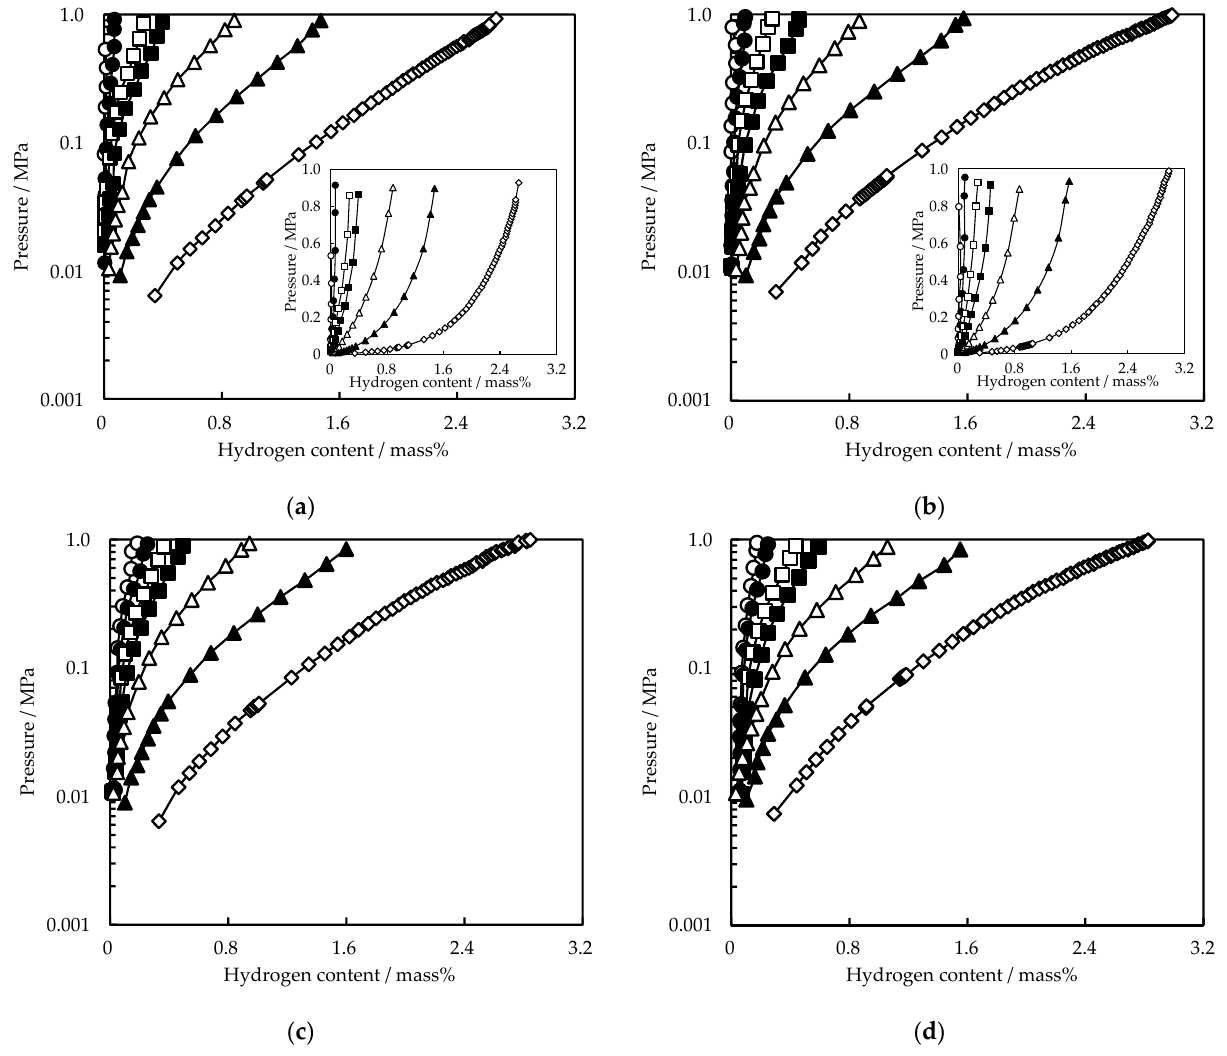
Figure 6. Hydrogen adsorption isotherms for ( a ) KB, ( b ) KB_0.6, ( c ) KB_4.9, and ( d ) KB_9.3. Tem- perature / K, ◇ : 77, ▲ : 98, △ : 123, ■ : 148, □ : 173, ● : 223, ○ : 273. The insets in ( a , b ) are hydrogen adsorption isotherms plotted by the linear pressure.